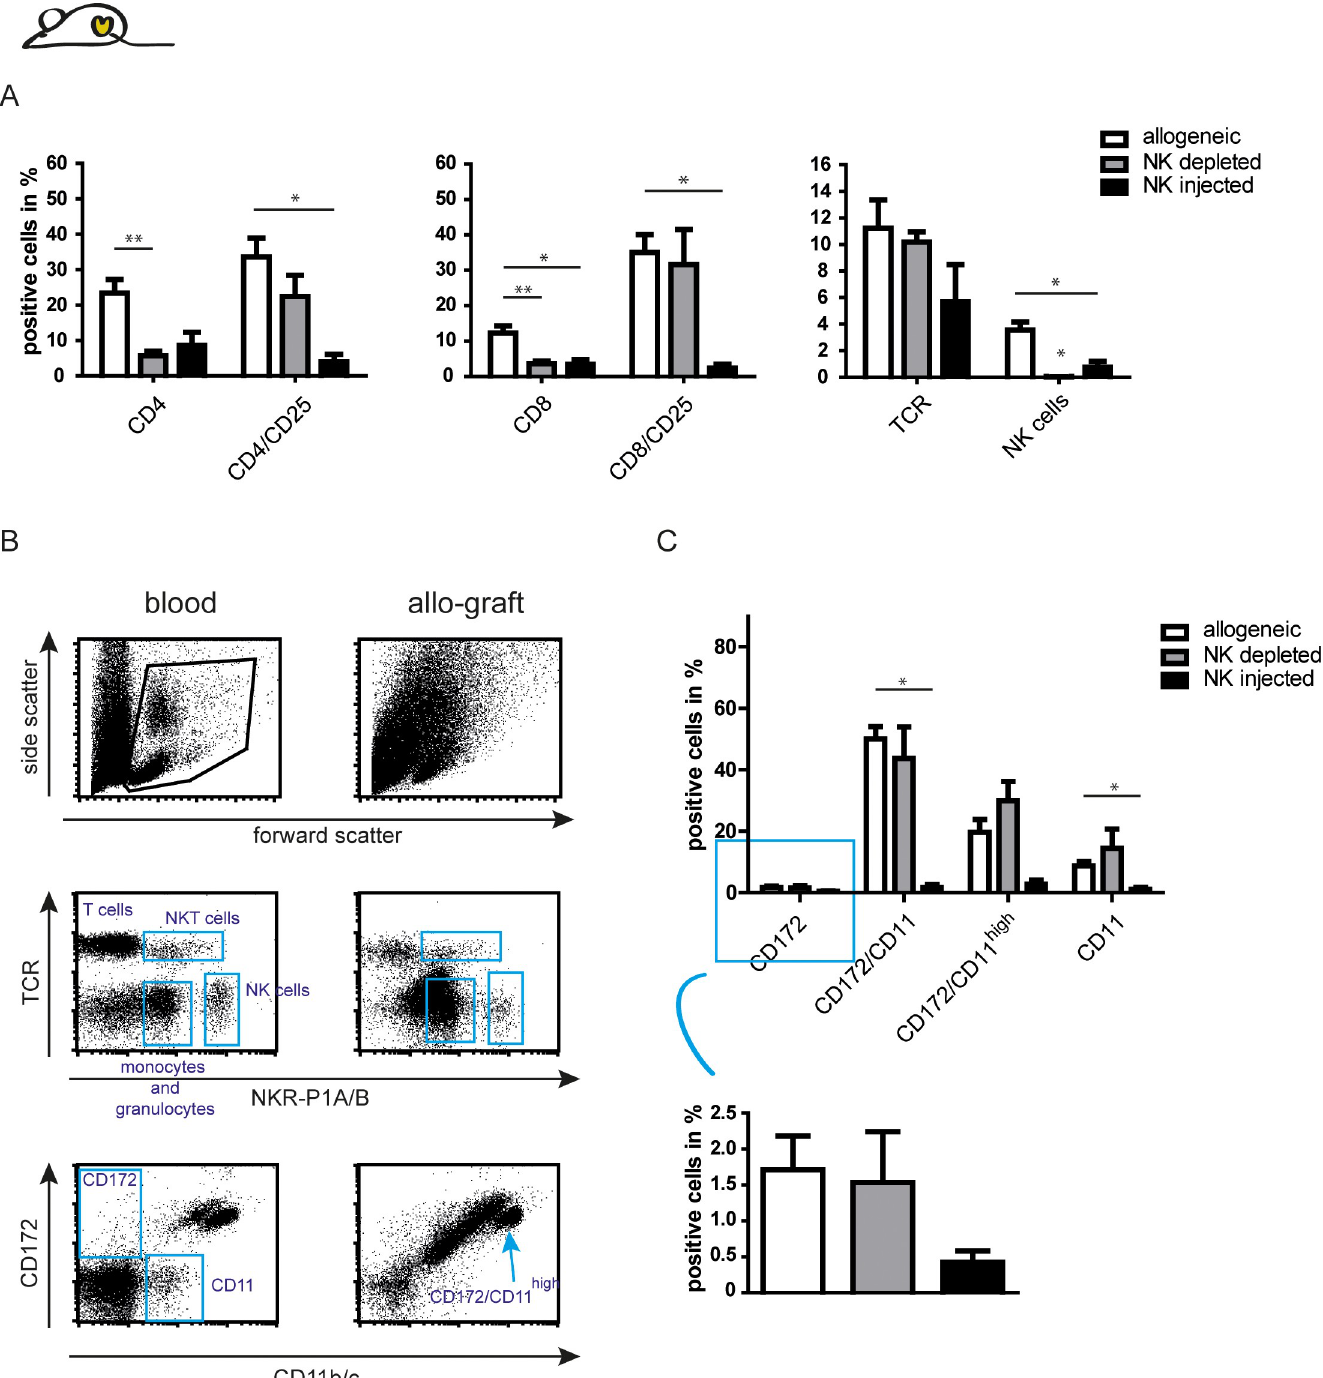
Fig 5. Graft infiltrating cells in Lew.1a recipients are affected by injection of activated syngeneic NK cells. (A) Flow cytometric analysis of Lew.1a derived infiltrates in allogeneic Lew.1u7B grafts in the specified group. In grafts of untreated Lew.1a recipients we observed increased fractions of CD4 + , CD8 + T cells and especially of activated T cells (CD25 + ). These percentages did not correlate with the analysis of TCR + cells, however, activated T cells often internalise their TCR, which might be an explanation for the discrepancy [26]. NK cells invaded the graft tissue only moderately. Depletion of NK cells led to a significant reduction of CD4 + / CD25 - and CD8 + /CD25 - cells, whereas the influx of activated T cells was unaffected. The injection of syngeneic NK cells on the other hand, almost completely abrogated the infiltration of activated T cells into the graft. (B) Dot blots of lymphocytes and granulocytes in the blood and allografts defined by TCR vs. NKR-P1A/B and CD172 vs. CD11b/c expression of untreated recipients. Monocytes were among the major graft infiltrating cells and could be further discriminated according to the MFI of the CD11b/c expression. (C) Summary of the flow cytometric analysis of CD172/CD11b/c expressing cells in the respective group. Graft rejection, in